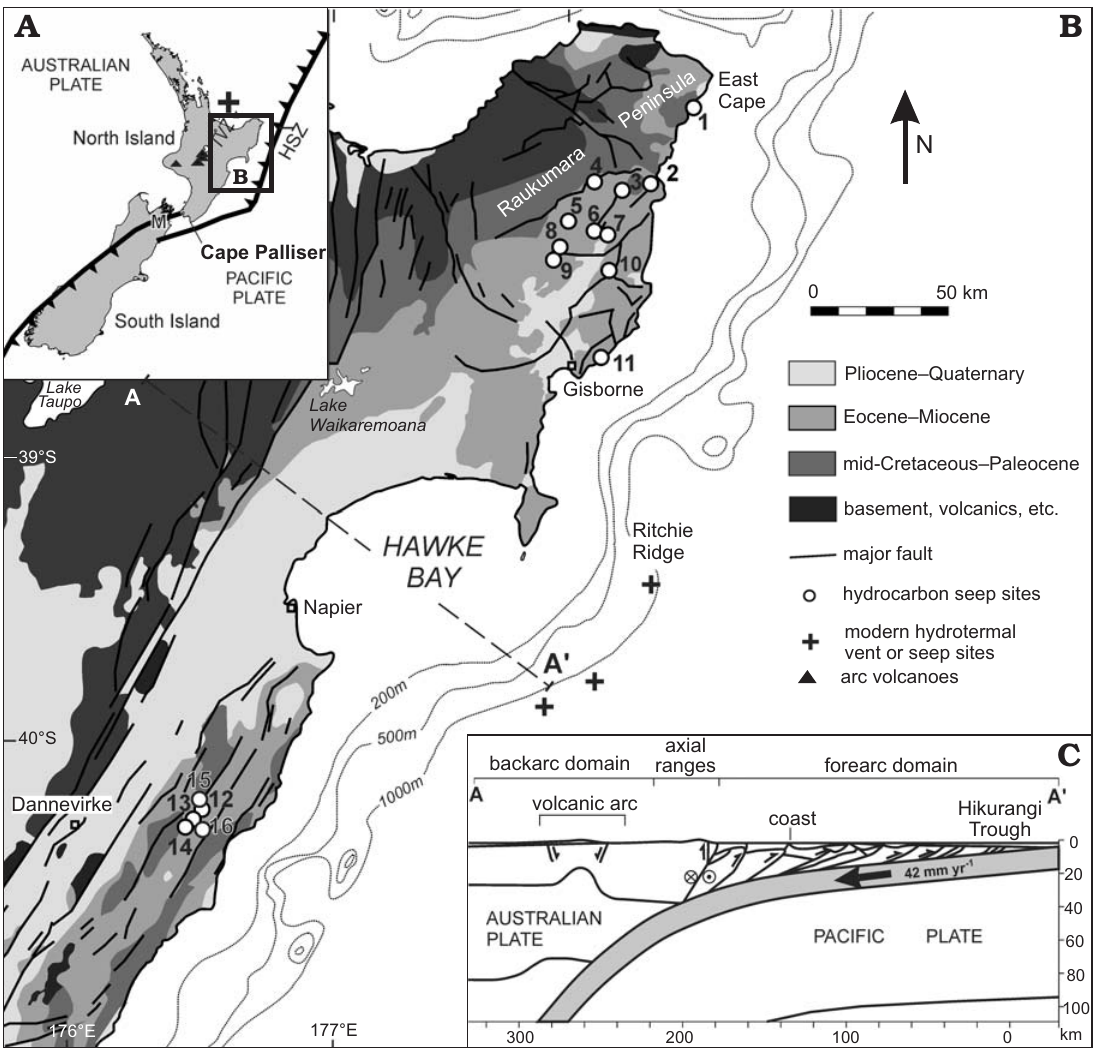
Fig. 1. Overview of the geology of the East Coast, North Island, New Zealand ( A , B ), showing locations of known Miocene hydrocarbon seep sites. Northern sites: 1, Waiapu; 2, Waipiro; 3, Karikarihuata; 4, Bexhaven; 5, Tauwhareparae; 6, Puketawa; 7, Totaranui; 8, Moonlight North; 9, Rocky Knob; 10, Waikairo; 11, Turi haua. Southern sites: 12, Wanstead; 13, Ugly Hill; 14, Haunui; 15, Ngawaka; 16, Wilder; HSZ, Hikurangi subduction zone; M, Marlborough; TVZ, Taupo Volcanic Zone. Also shown are some of the modern offshore hydrocarbon seep sites of the Hikurangi subduction margin, and a hydrothermal vent location (inset). C . Cross-section (modified from Barnes et al. 2010) shows transpressive subduction of the Pacific Plate beneath the Australian Plate, and relationships of tectonic elements of the northern New Zealand plate margin (see Campbell et al. 2008 and Barnes et al. 2010 for further details on geologic context). The fossil lucinids of this study are described from fossil seep locations 4, 8, 9,